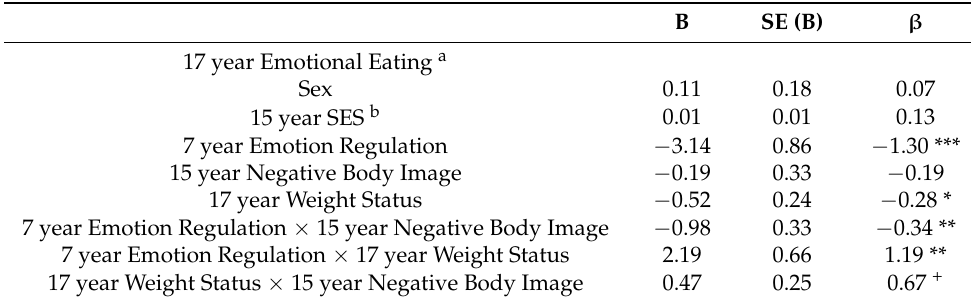
Table 2. Regression analysis on associations between 7 year emotion regulation, 15 year weight status, 15 year negative body image, and 17 year emotional eating.